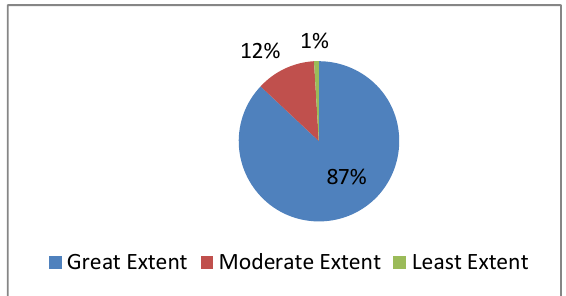
Fig. 1. Use of the balanced scorecard in performance